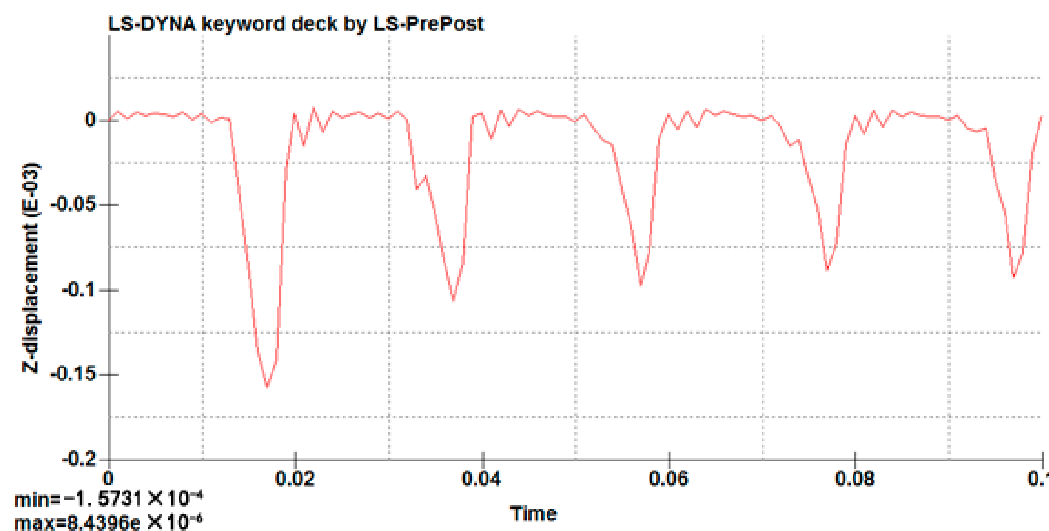
Figure 18. Displacement on mid-point of weld under 50 Hz. After the system is stable (the fifth cycle), the displacement at the mid-point of the weld shows alternating changes with time in the positive and negative direction; the maximum value of downward deformation of the plate in the upper half of the cycle is 5.3 × 10 − 6 m. The maximum value of the upward deformation in the second half of the cycle is 9.1 × 10 − 5 m.